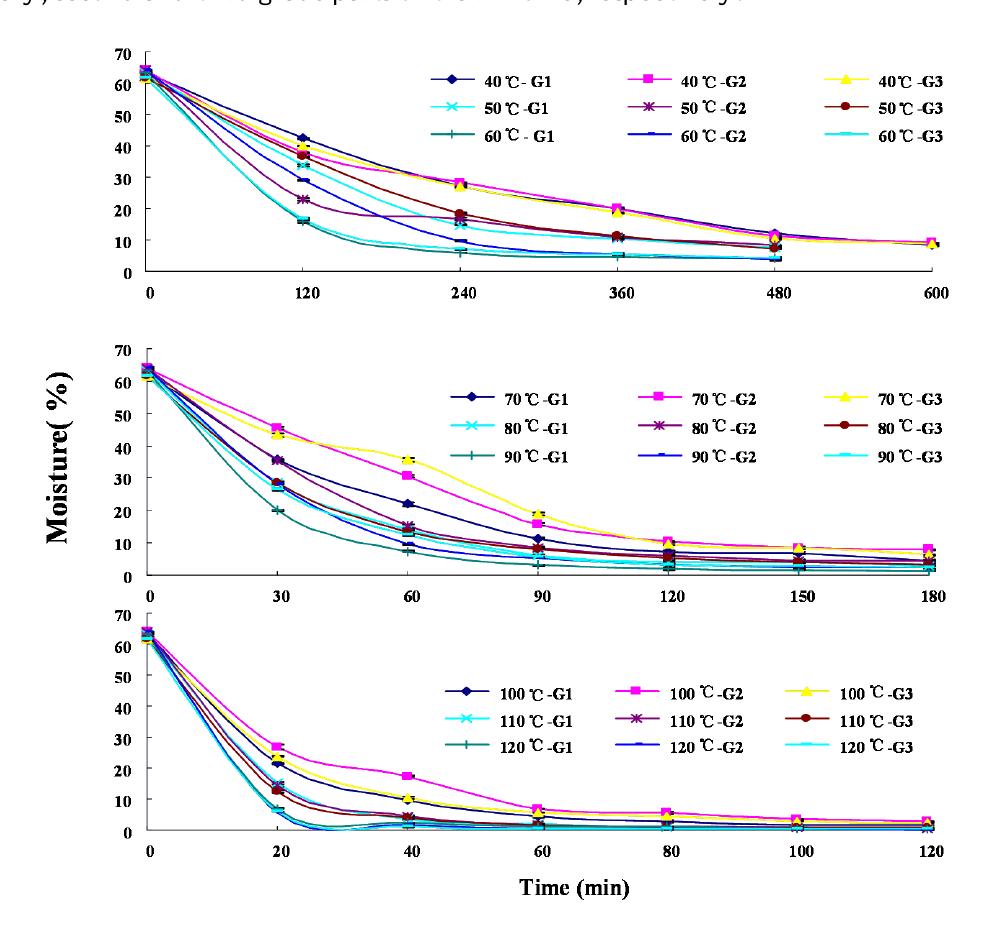
Figure 2. Dehydration curves of samples at different drying temperatures during the thermal drying process of the three grades parts of rhizomes of B. chinensis . G1 , G2 and G3 are the primary, second and third grade parts of the rhizome,